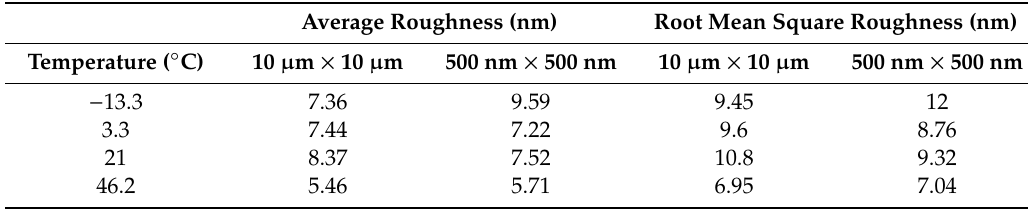
Table 2. Surface roughness of (PAH/DY) 6.5 on glass.